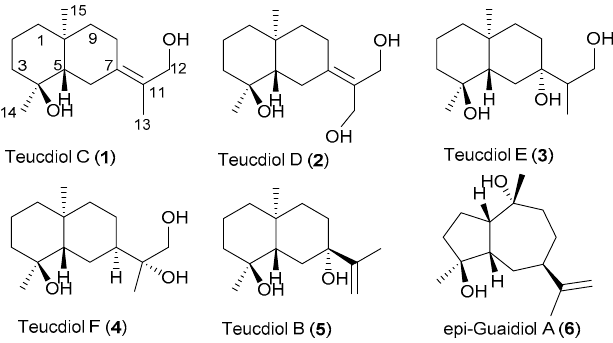
Figure 1. The chemistry structures of compounds 1 – 6 .